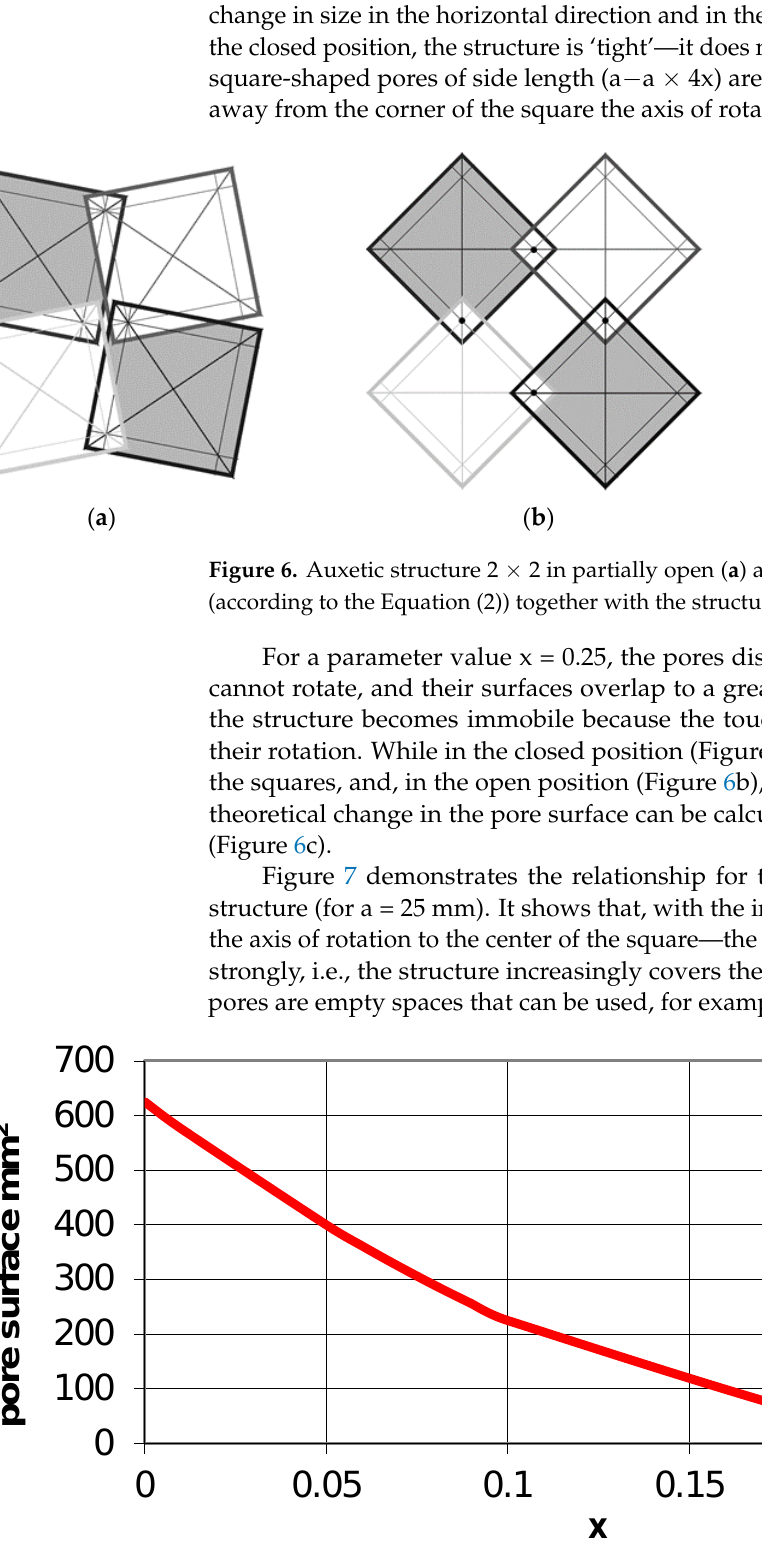
The presented at Figure 6 auxetic structure of the type 4 × 4 is characterized by the